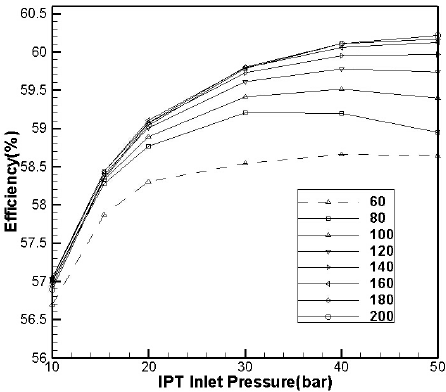
Figure 10. Effects of HPT inlet pressure on ( a ) HR and ( b ) ER under different IPT inlet pressures.